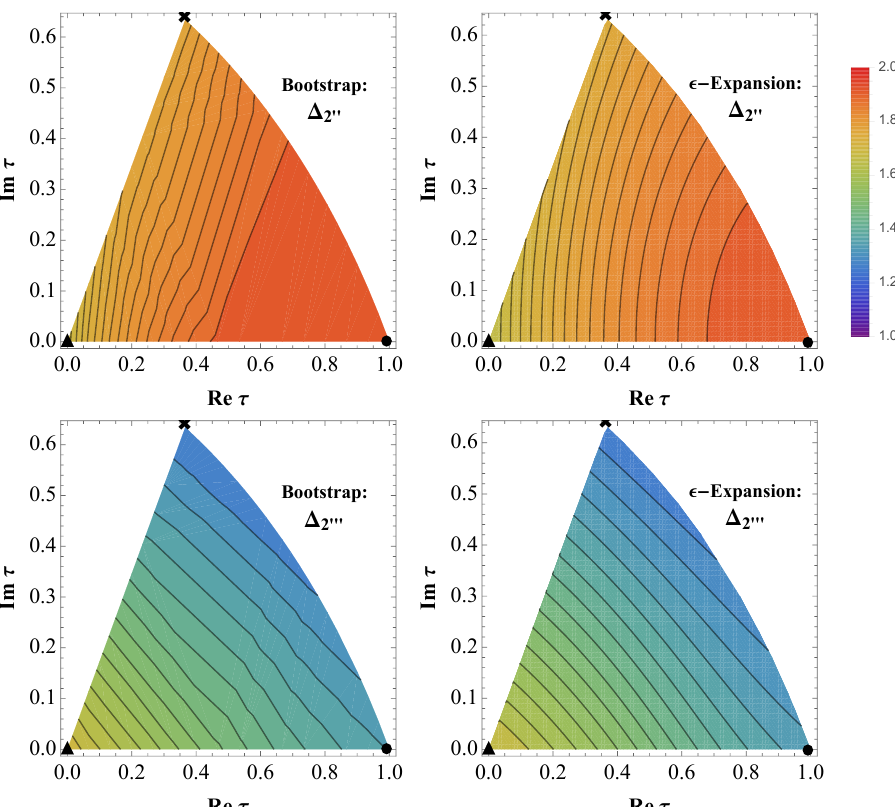
Figure 8 . Left: upper bounds on the doublet scaling dimensions (cid:1) 2 00 and (cid:1) 2 000 for all (cid:28) in the fundamental domain F de(cid:12)ned in (cid:12)gure 1, computed using the G (cid:13)avor symmetry crossing equations with (cid:3) = 19. Right: resummed 3-loop 4 (cid:0) " expansion values for these same quantities. In all plots the cross, circle, and triangle denote the enhanced symmetry points (cid:28) = 1 cWZ 3 , and XYZ models respectively.